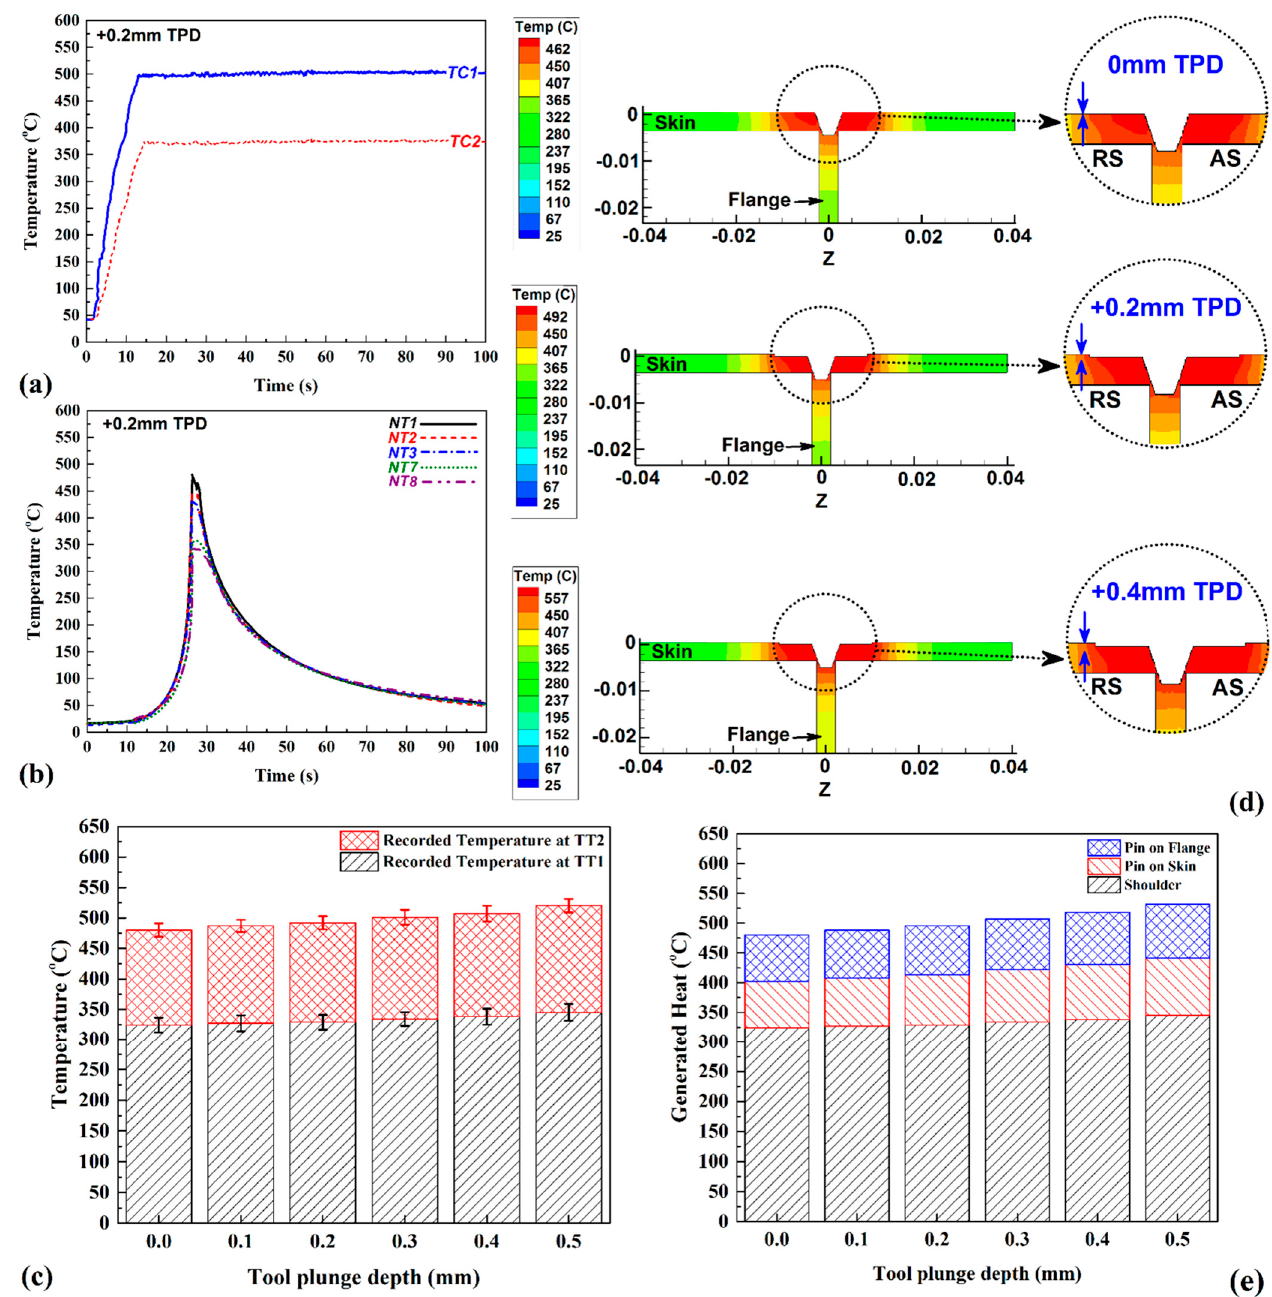
Figure 3. ( a ) Recorded temperature inside the FSW tool. ( b ) Recorded surface temperature of the joint. ( c ) Recorded temperature inside the FSW tool at various TPDs. ( d ) Cross-sectional view of the simulation results of internal heat flow. ( e ) Simulation results of generated heat at various TPDs.